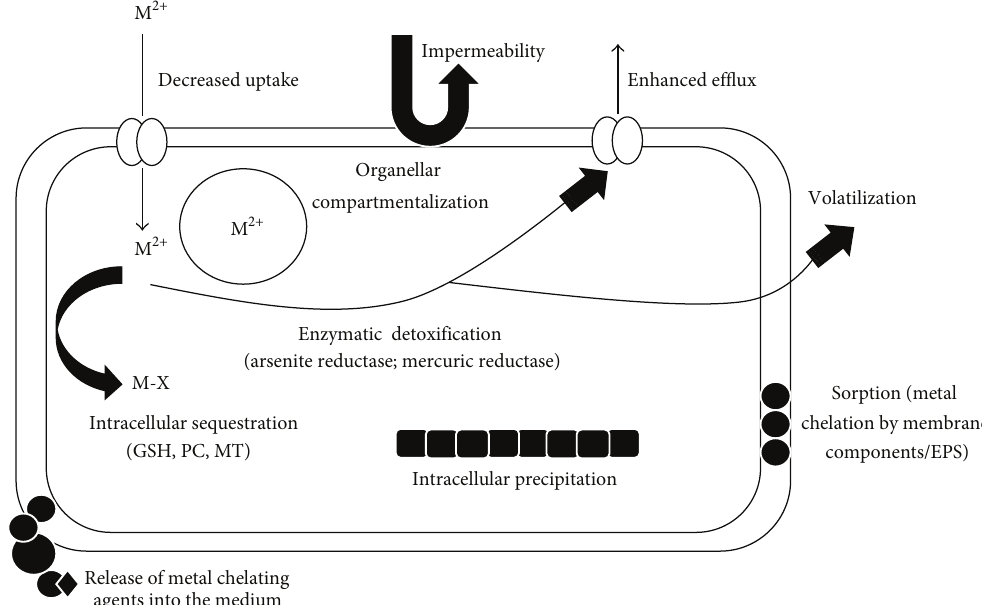
Figure 1: General mechanisms adapted by bacteria, eukaryotes, and archaea for metal resistance. All the three domains exhibit sorption of metals, volatilization, release of metal chelating compounds in the medium, enhanced efflux, impermeability, decreased uptake, enzymatic detoxification, and intracellular chelation as mechanisms for metal resistance. Organellar compartmentalization is observed only in eukaryotes, with the exception of magnetosomes in magnetotactic